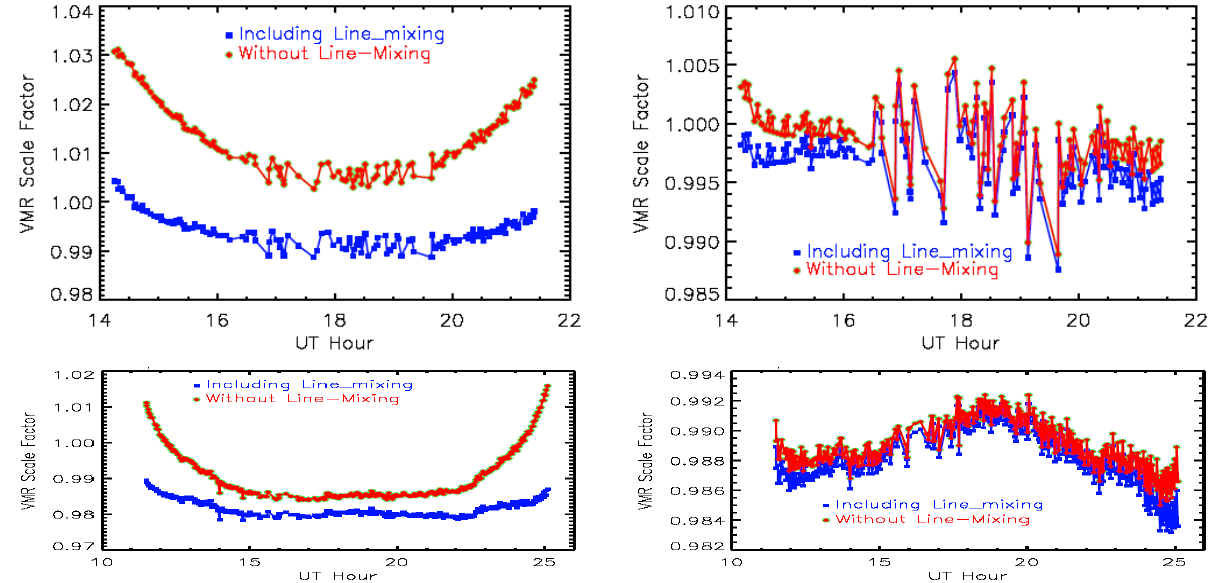
Figure 9. Scaling factor, applied to the a priori CO 2 vmr profile deduced from in situ measurements (see text) retrieved in Band#1 (left panels) and Band#2 (right panels) versus the Universal Time of the measurement obtained with (blue) and without (red) the inclusion of LM in the forward model. The upper and lower plots are for December 22, 2004 and June 18, 2008, respectively.